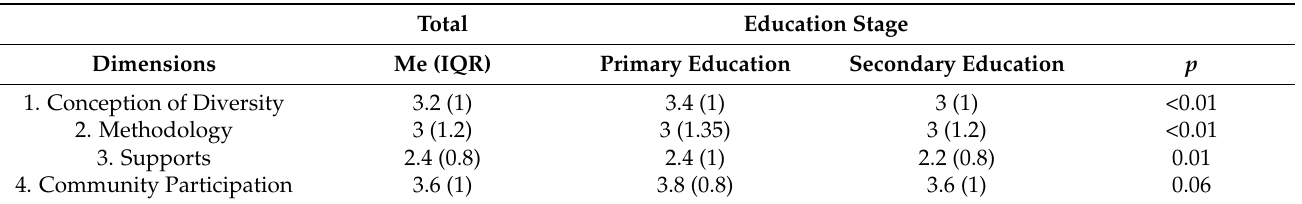
Table 3. CEFI-R descriptive analysis and differences of each Dimension, searching for differences